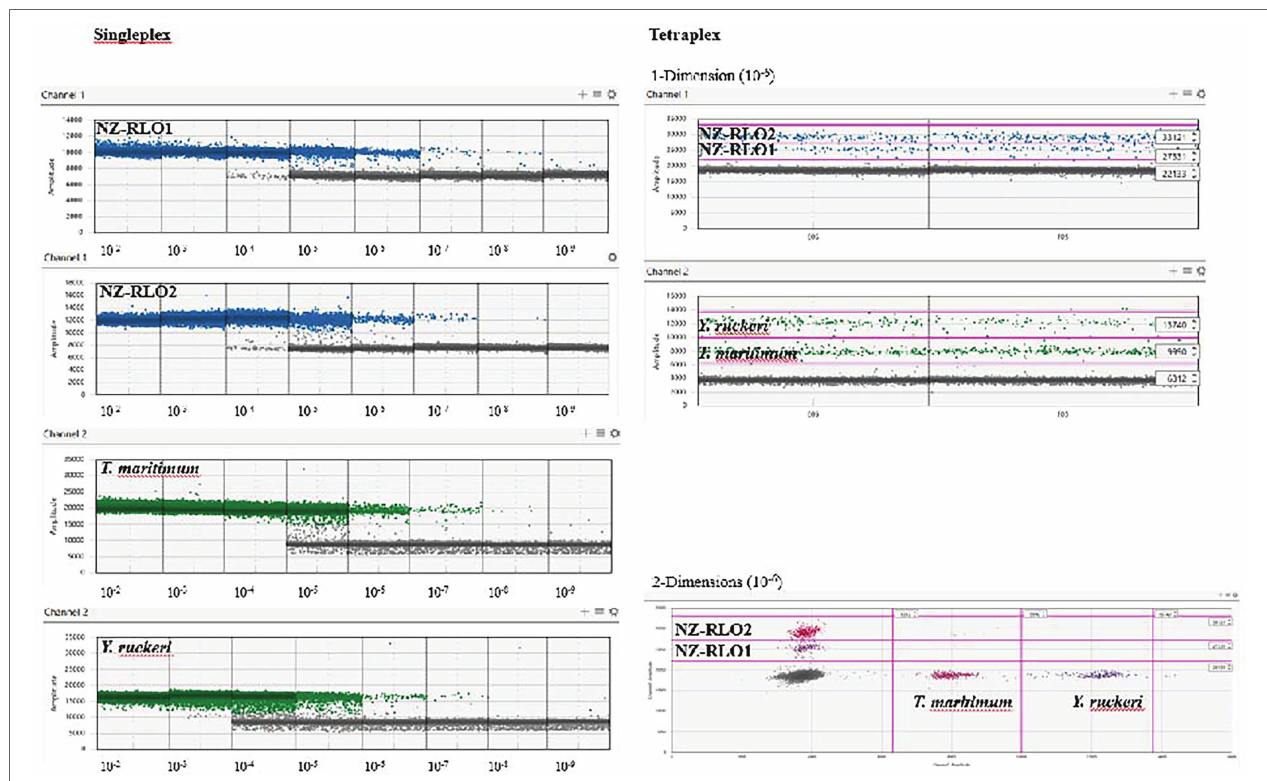
FIGURE 2 | Droplet digital PCR results on singleplex (left) and tetraplex (right) assays visualized using the QuantaSoft ™ Analysis Pro software (version 1.0.596) on a 10-fold gBlocks ™ dilution series for NZ-RLO1, NZ-RLO2, Tenacibaculum maritimum , and Yersinia ruckeri , starting from 10 ng/ μ l. Tetraplex outputs are only displayed for concentration of 10 − 6 ng/ μ l. Blue and green dots are positive droplets on the FAM and HEX channel, respectively. Gray dots are counted as negative